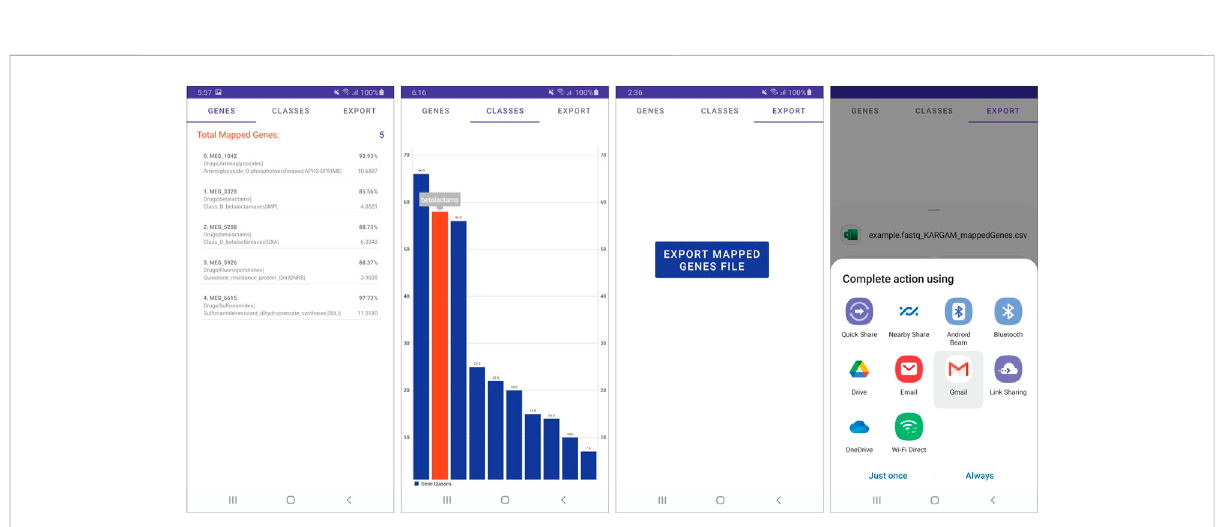
FIGURE 4 Screenshots of the KARGAMobile app after completing a run, showing (from left to right) the ARG coverage and depth summaries in textual mode, the visual charts of ARGs grouped by AMR classes, and the export/sharing data